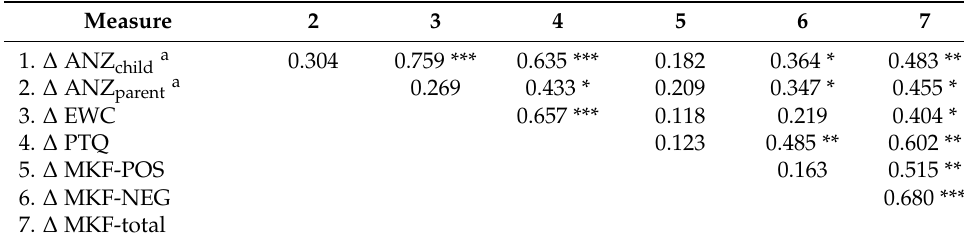
Table 3. Intercorrelations among change-scores from pre- to posttest.